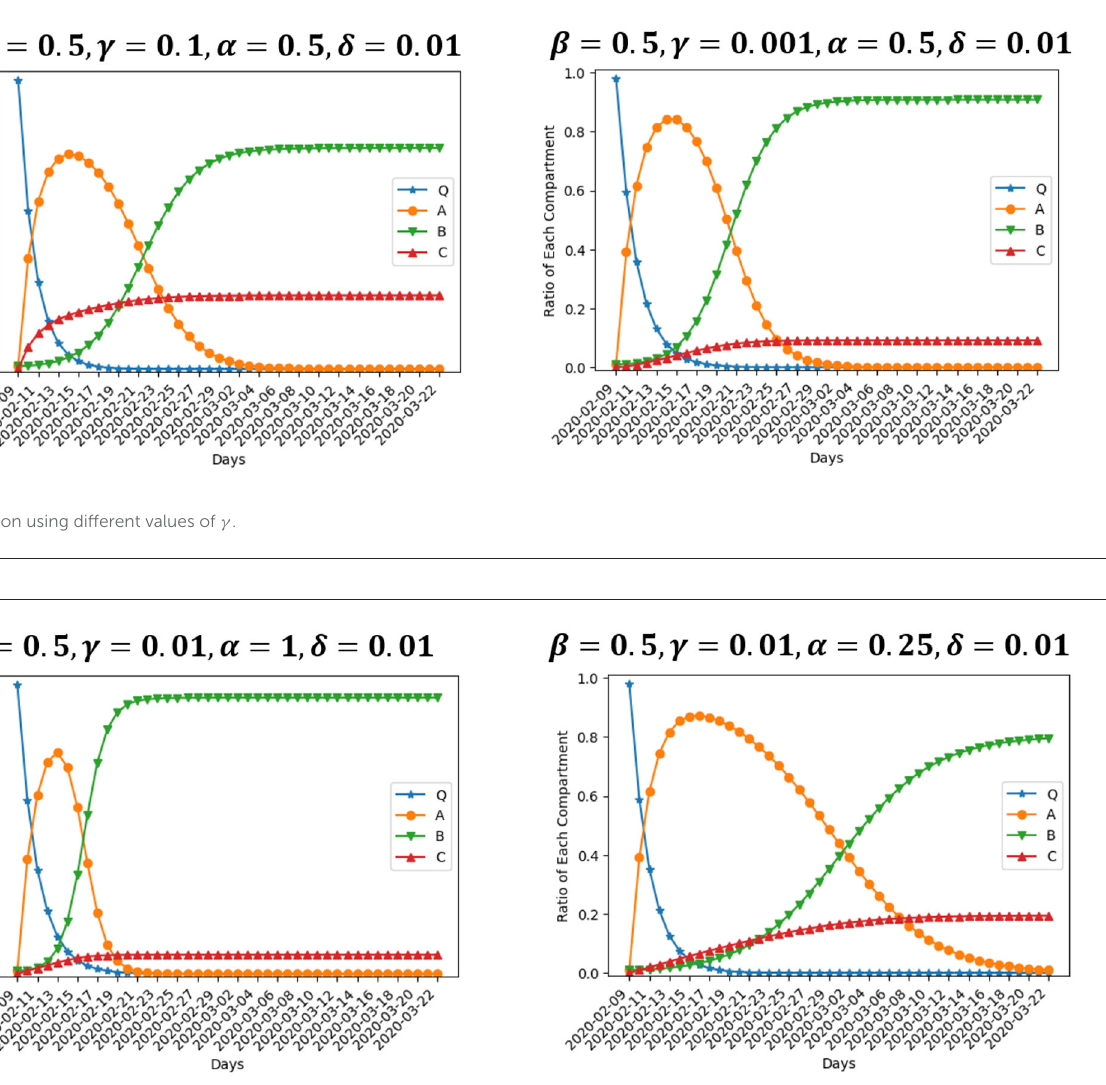
FIGURE6 Simulation using different values of α